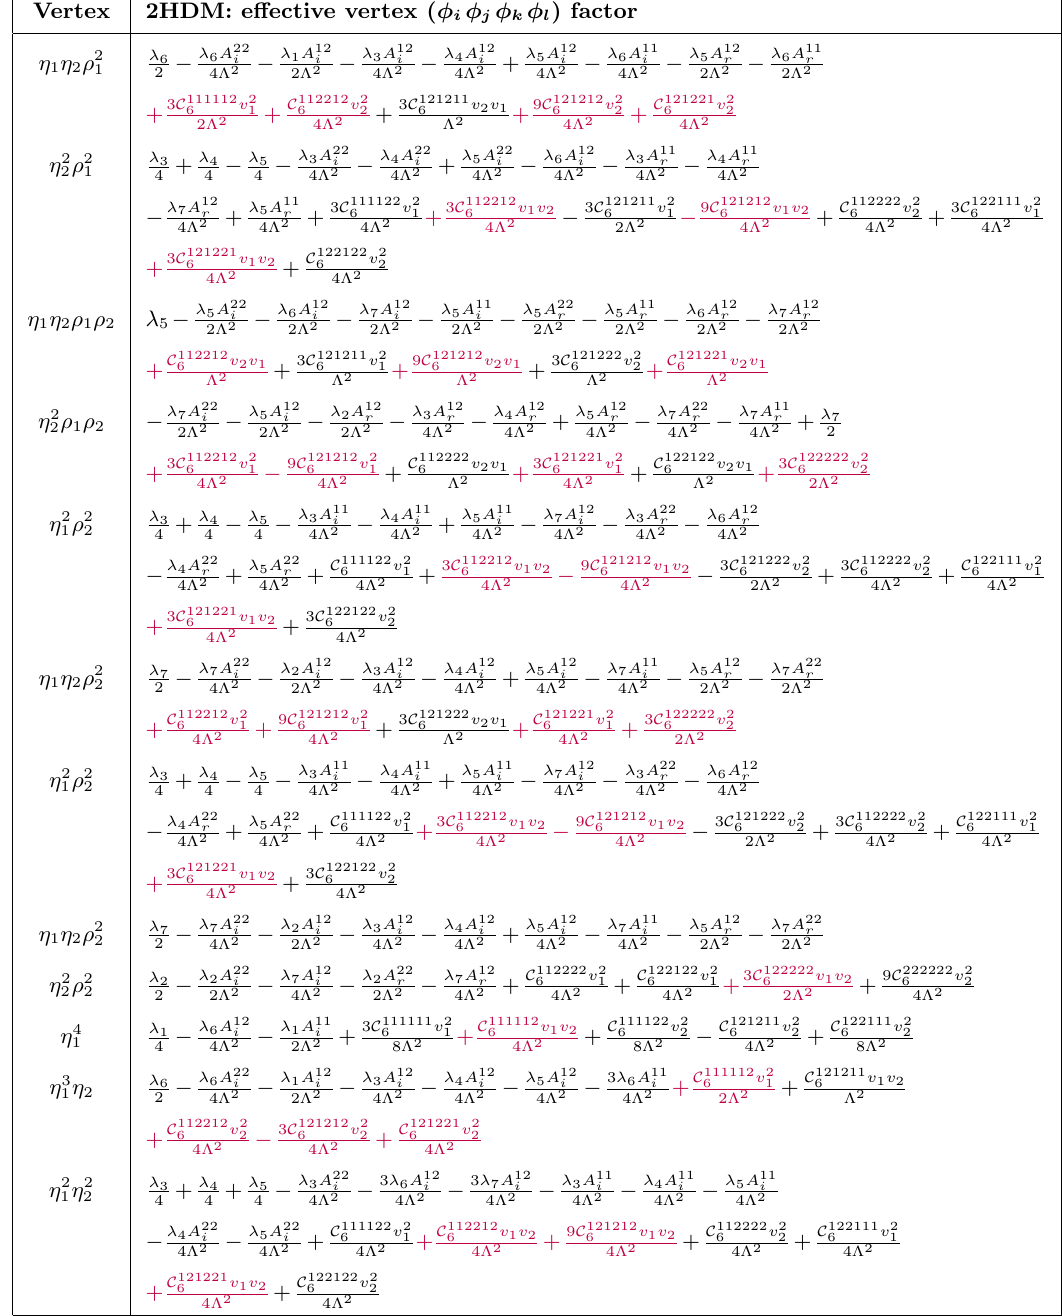
Table 49. 2HDM: scalar four-point vertices in the unphysical basis.